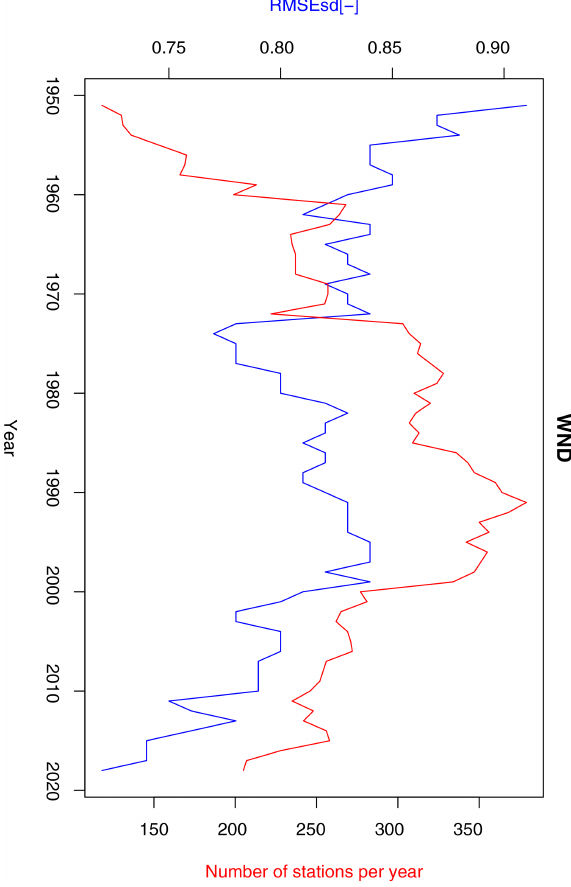
Figure 19. Annual RMSEsd median (blue) and number of available stations per year (red) for wind speed in the period 1951–2019. The daily results, also summarized in Table 1, were used for calculating the annual